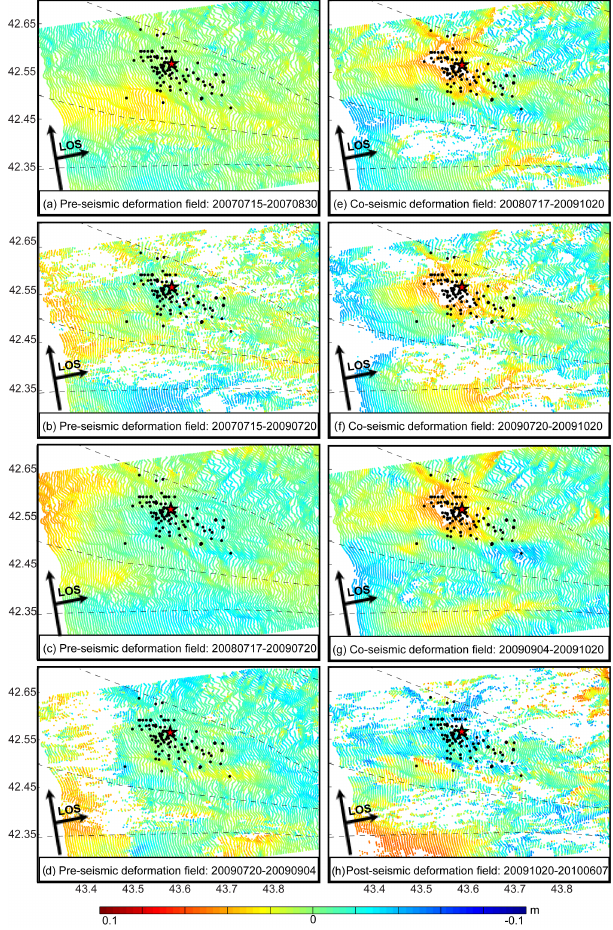
Figure 2. (a–d) Pre-seismic, (e–g) co-seismic and (h) post-seismic deformation fields. The star is the location of the main shock 2009. The black dots are the epicenters of the aftershocks from 2009 with magnitudes greater than 4 (from the catalog of the Seismic Moni- toring Center (SMC) in Georgia, www.seismo.ge). Major faults are shown by black dashed lines (Gamkrelidze and Shengelia, 2007). Red colors represent movement toward the ascending